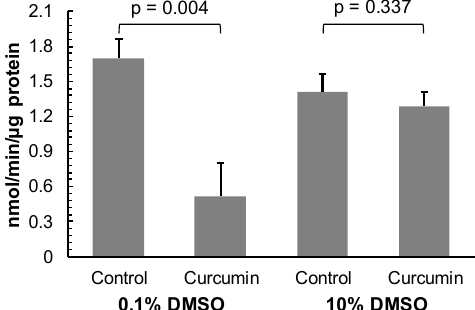
Figure 4. Reversibility of inhibition of rhodesain by curcumin. Purified rhodesain (3.4 µ g / mL; 100 nM) was pre-incubated in 100 mM citrate, pH 5.0, 2 mM dithiothreitol with 100 µ M curcumin in the presence of 0.1% or 10% DMSO. For controls, the enzyme was incubated under the same conditions but in the absence of curcumin. After 30 min, the mixture was diluted 1:100 into 100 mM citrate, pH 5.0, 2 mM dithiothreitol, 2% DMSO, 5 µ M Z-FR-AMC. After 10 min, the release of liberated AMC was recorded. The specific activity (nmol AMC released / min / µ g protein) was calculated using a standard curve constructed with uncoupled AMC. Data are mean values ± SD of three experiments.